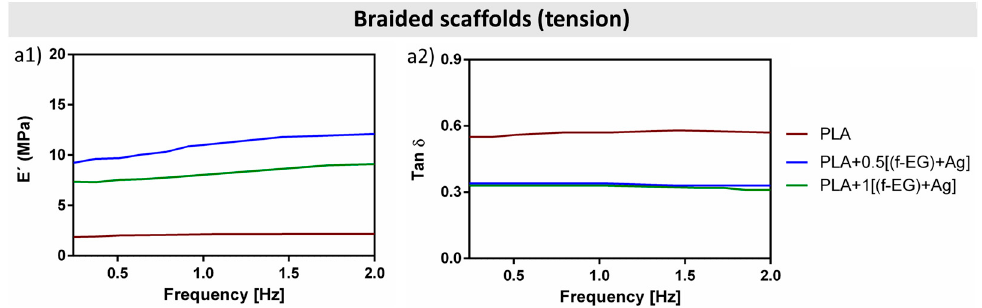
Figure 11. ( a1 ) Storage modulus (E ′ ) and ( a2 ) loss factor (tan δ ) of braided scaffolds, as a function of the frequency, ranging from 0.1 to 2 Hz. Braided scaffolds were tested in tensile